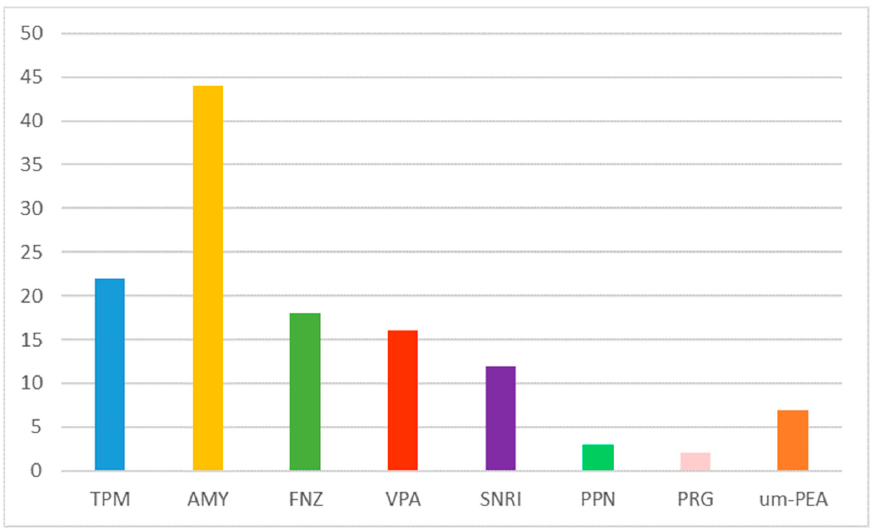
Figure 1. Prophylactic medications taken before starting OBT-A (frequency). AMY: amitriptyline;